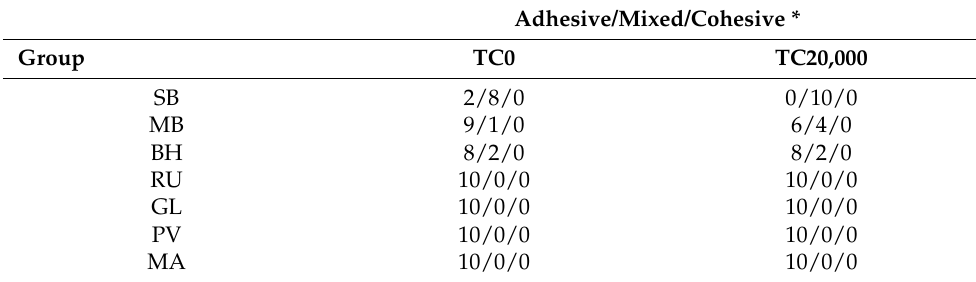
Table 4. Failure modes of the various experimental groups in the TBS